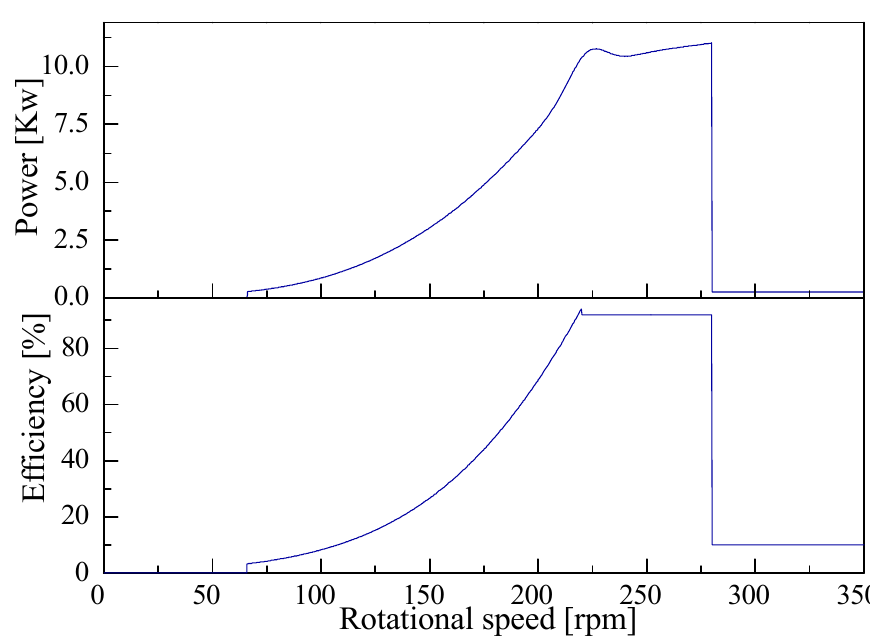
Figure 11. Generator power and efficiency curve.